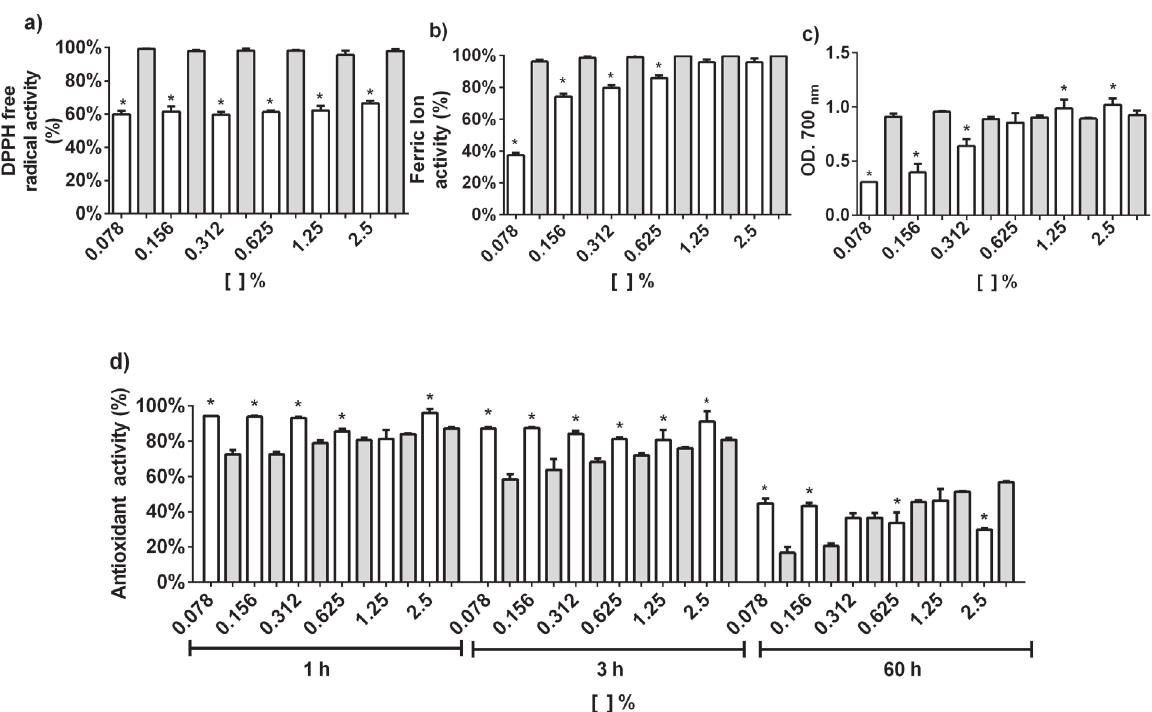
Figure 2 - Antioxidant activity of the isoflavone from Myroxylon peruiferum l.f. Test DPPH ( a ), FRAP ( b ), FIC ( c ) and BCB ( d ). White column: sample; Gray column: positive control.* Statistically significant in relation to the positive control, when p <